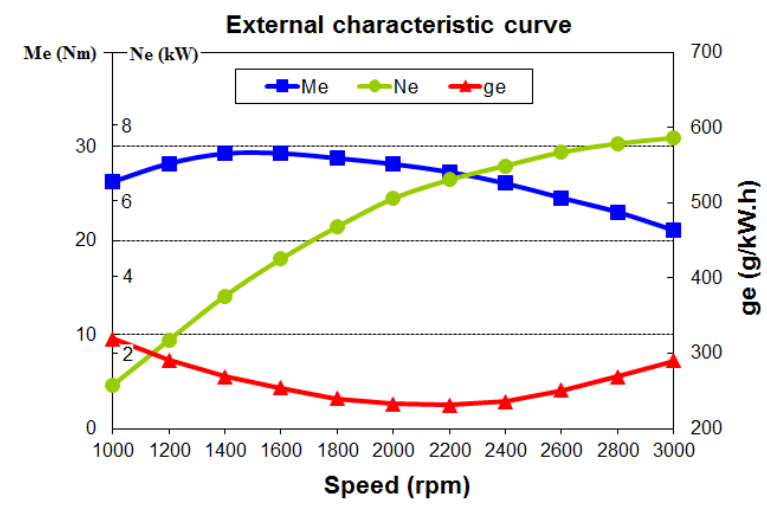
Figure 3. External characteristic of engine.